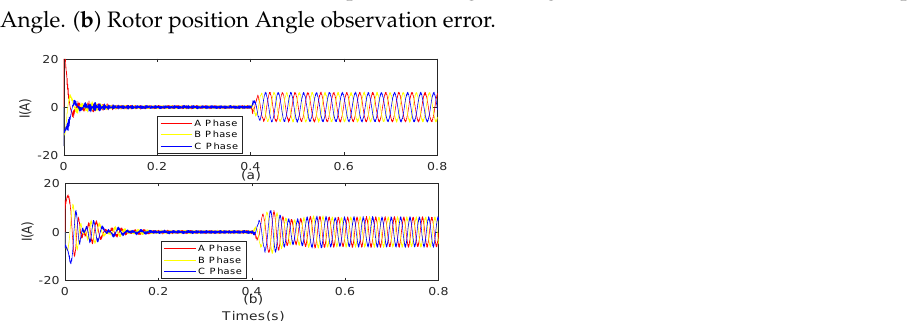
Figure 22. Phase current response process under two control methods. ( a ) Current response under the proposed VPDPI control. ( b ) Current response under the PI control method.